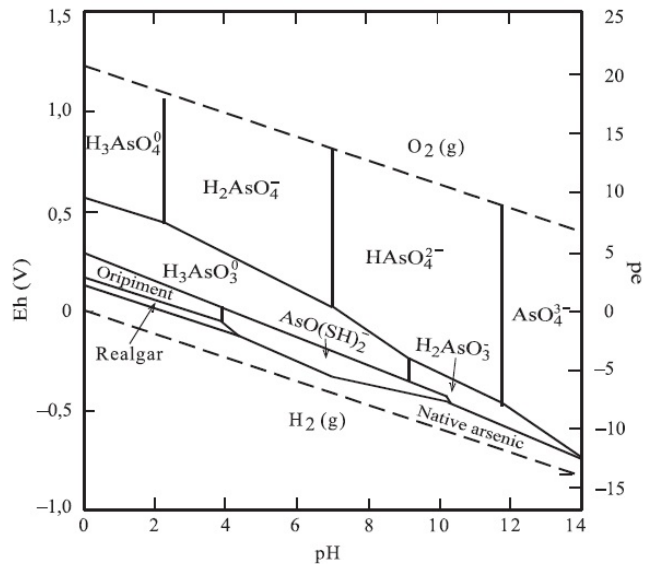
Fig. 2. Eh-pH diagram for As-S-H О system at temperature 25 о С and 1 bar pressure [11, Figure 2. Eh-pH diagram for As-S-H 2 О system at temperature 25 о С and 1 bar pressure 2 [11, 13].